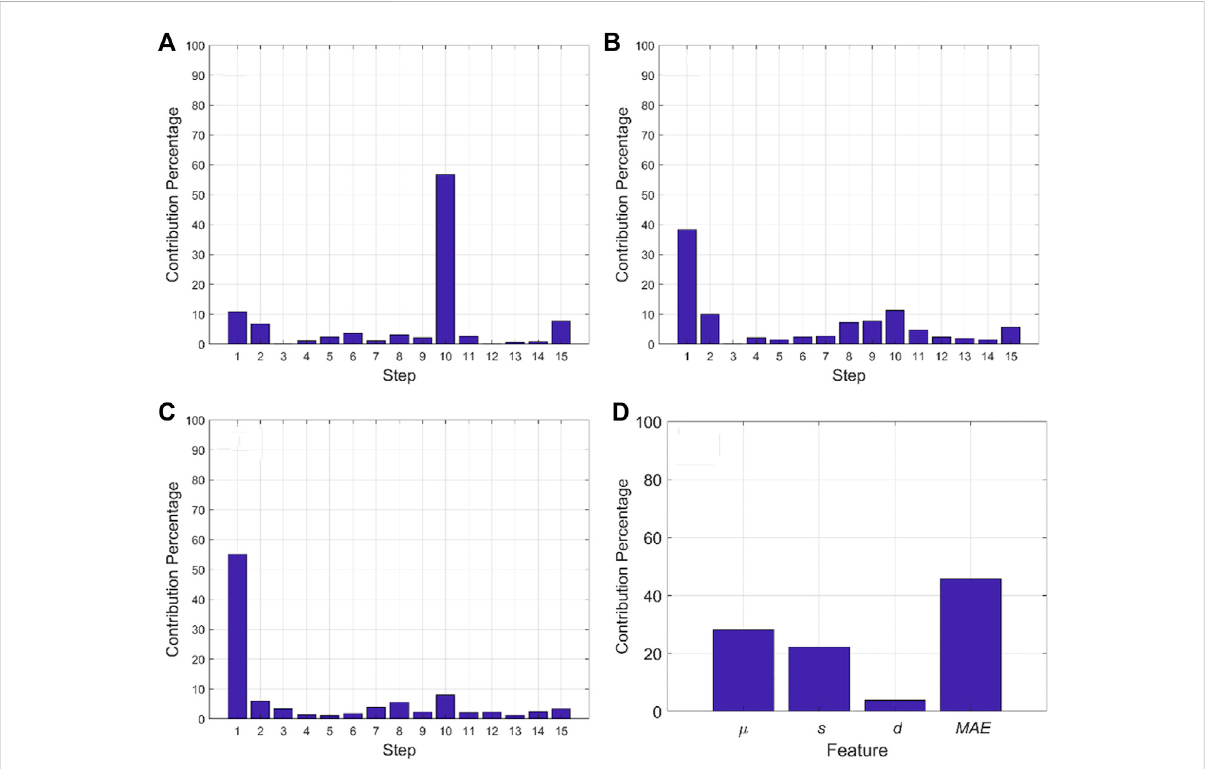
FIGURE 9 Step-wise faultdiagnosisforcyclefouroffaultscenario1 (A) MPCA SC (B) MPCA DTW ,and (C) FSM,and (D) feature-wisefaultdiagnosisfromFSM. MPCA SC wrongly attributes the fault to step 10, while both MPCA DTW and FSM correctly attribute the fault to step 1. FSM also shows the clearest diagnosis among all methods. FSM can also further drill down the fault to the feature level where the mean ( μ ) and MAE are identi fi ed as the most signi fi cant contributor to thefault,correctly indicating that there might bea signi fi cant shift in pressure pro fi le during step 1 of the faulty